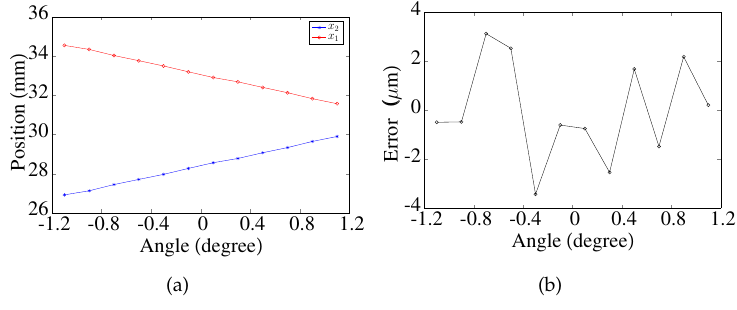
Figure 6. ( a ) Values of x 1 and x 2 ; ( b ) Extreme error of AVG